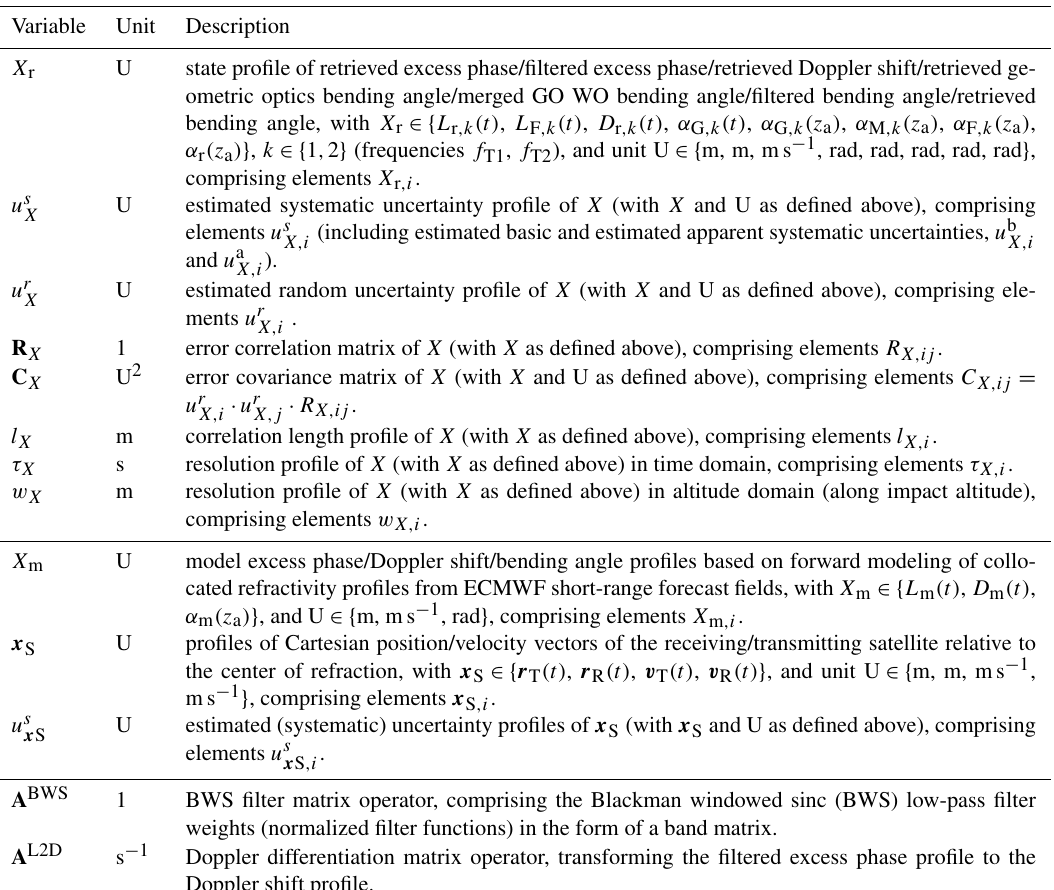
Table 1. Principal variables for the rOPS L1b uncertainty propagation.